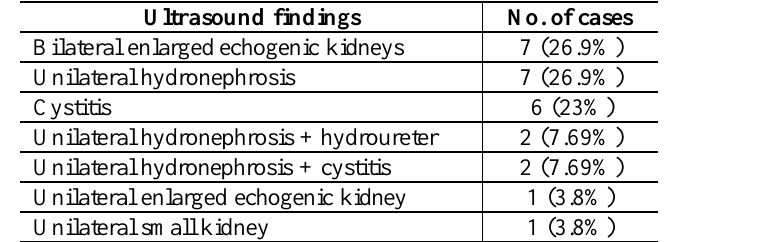
Table V : Abnormal ultrasound findings